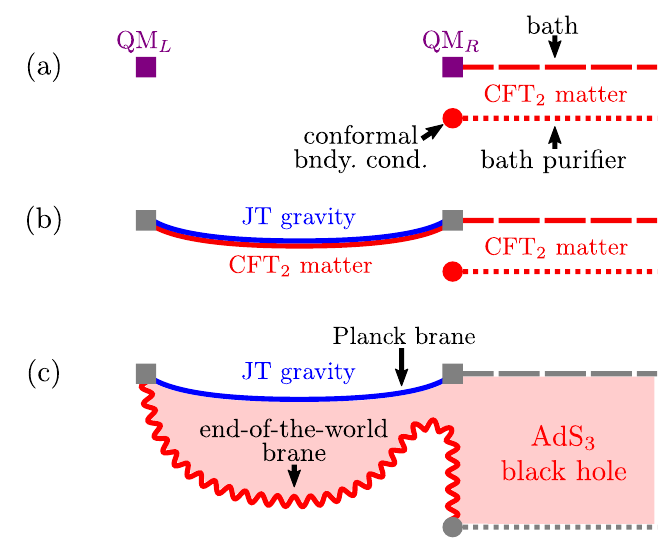
Figure 1 . In the AEM 4 Z model, the holographic principle is invoked twice, resulting in three different pictures of the same physical system. In our present analysis of this model, we include a thermal bath at finite temperature. In the top picture (a), there are two quantum mechanical systems (QM and QM ), as well as a two copies of the field theory (CFT 2 ) on a half-line (dashed L R and dotted). Both of the quantum mechanical and field theory systems are prepared in independent thermofield double states. The middle picture (b) introduces the two-dimensional holographic geometry (JT gravity) dual to the entangled state of QM and QM . This gravitating region also L R supports the same CFT 2 that appears in the bath region. The last picture (c) contains the doubly- holographic description, where the holographic CFT is replaced by an AdS 3 bulk, and in particular, the thermofield double is replaced by a bulk region with the geometry of an AdS 3 black